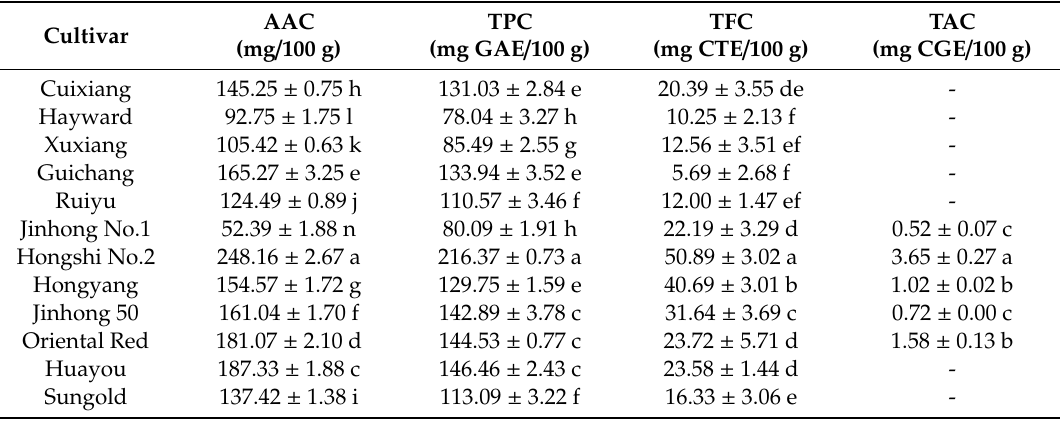
Table 2. AAC, TPC, TFC and TAC of 15 kiwifruit cultivars.